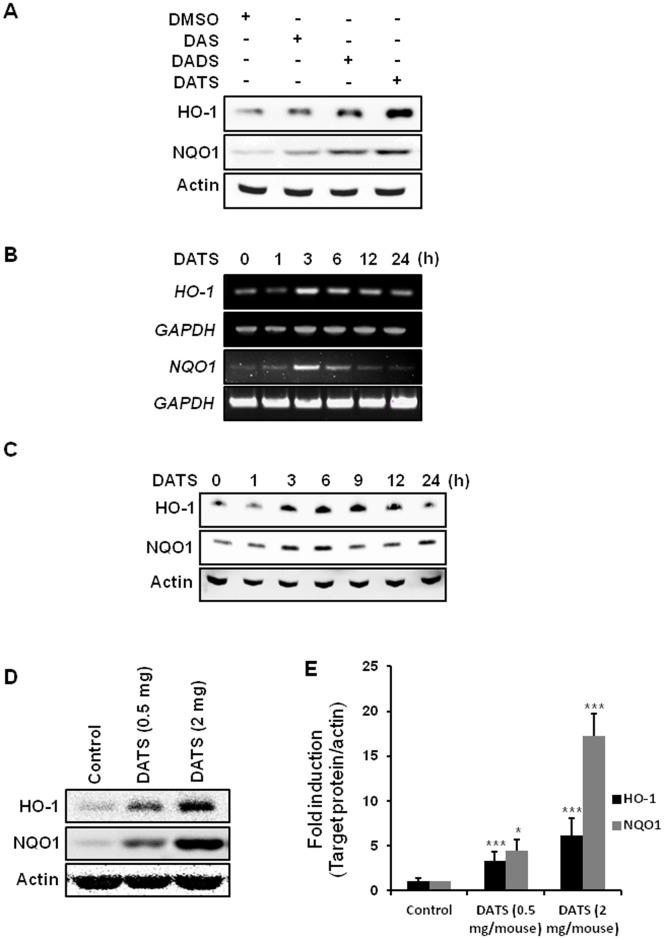
DATS induces the expression of HO-1 and NQO1.(A) AGS cells were incubated with DAS, DADS, or DATS (20 µM each) for 6 h, and the protein expression of HO-1 and NQO1 was determined by Western blot analysis. Actin was detected to ensure equal protein loading. (B) Total RNA was isolated from cells treated with or without DATS for indicated duration and was analyzed by RT-PCR for detecting the levels of HO-1 and NQO1 mRNA, as described in Metarials and Methods. GAPDH was used as a control for equal lane loading. (C) The expression of HO-1 and NQO1 in AGS cells incubated in the presence or the absence of DATS (20 µM) for the indicated duration was assessed by Western blot analysis. (D) C57BL/6 mice were given DATS (0.5 or 2 mg per mouse) suspended in sodium-CMC or vehicle alone as described in Metarials and Methods. After 2 weeks, stomach tissues were collected, and the protein lysate was prepared. The effect of DATS on the expression of HO-1 and NQO1 was assessed by Western blot analysis. (E) Data are represented as fold induction of protein expression. Data are means ± SEM (n = 5); **, *** Significantly different as compared to control (p<0.01, 0.001 respectively).